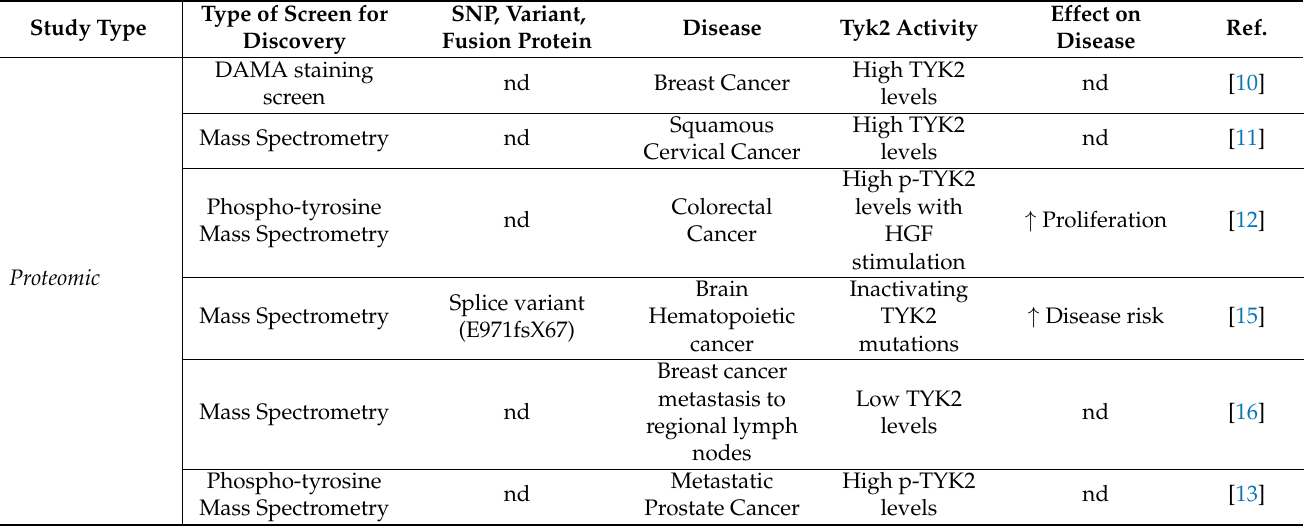
Table 1. Genomic, transcriptomic and proteomic studies identify TYK2 mutations and expression in cancer. Type of Screen Study Type